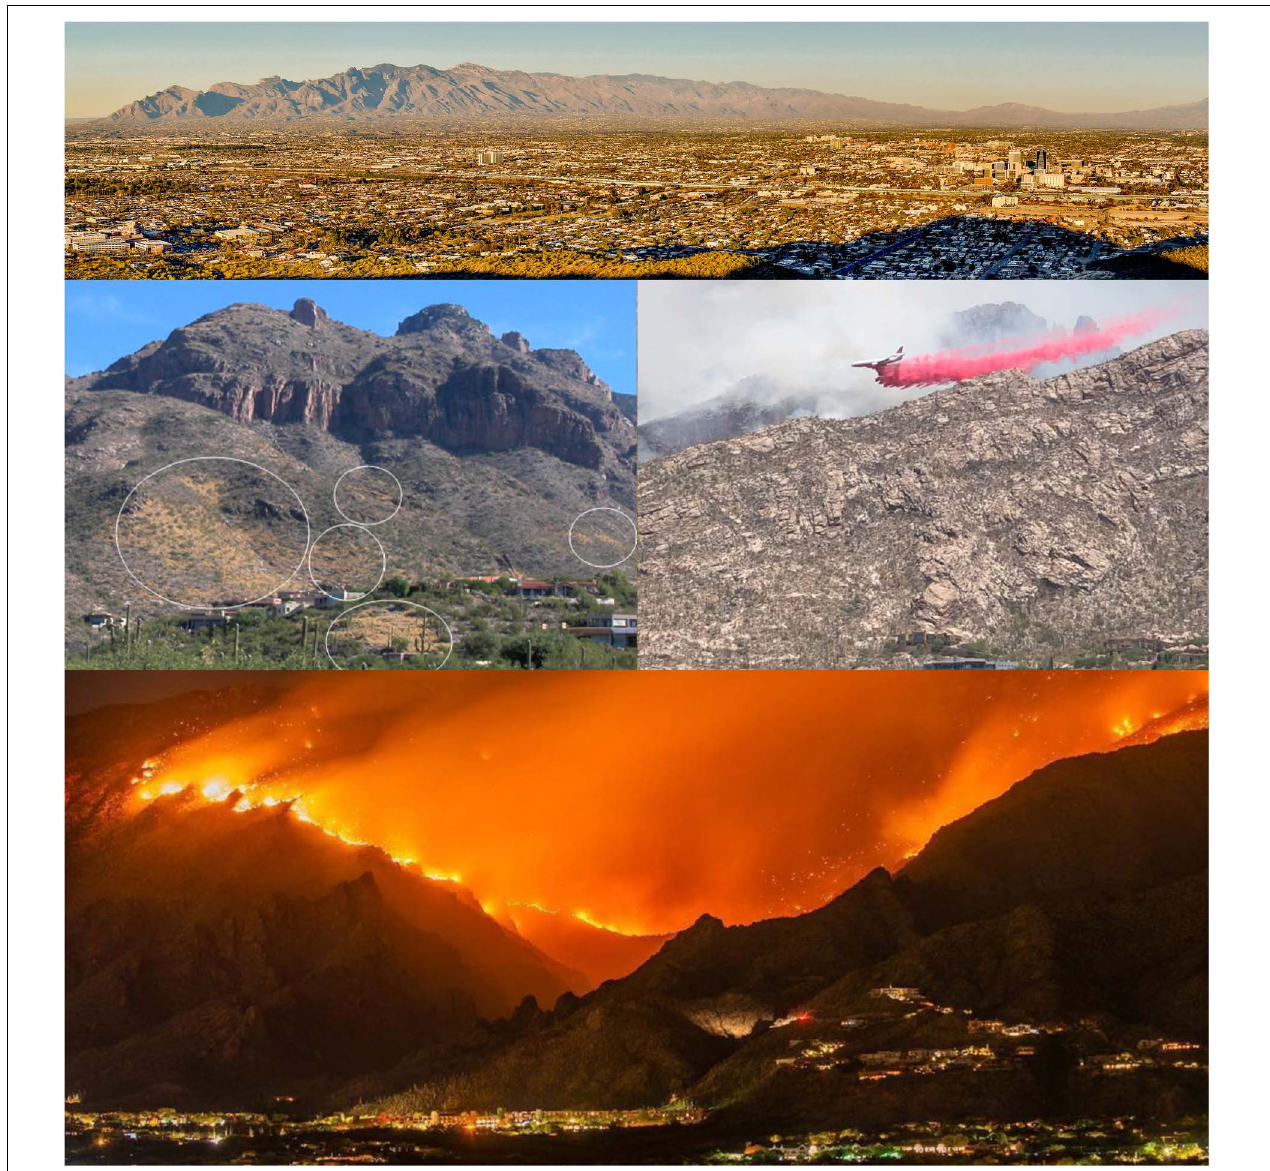
FIGURE 2 | The Santa Catalina Mountains and 2020 Bighorn Fire, Tucson, Arizona. Counter clockwise from top: Looking north over the of City of Tucson to the Catalina Mountains from Tumamoc Hill, photo by Paul Mirocha; front range of the Catalinas with buffelgrass infested south-facing slopes (yellow patches inside white circles), photo courtesy of the Arizona-Sonora Desert Museum; The Bighorn Fire dropping down the front range of the Catalinas into Ventana Canyon and the Tucson wildland-urban interface, 20 June 2020, photo by A.T. Willett; slurry bomber dropping retardant just above the WUI on the front range of the Catalinas,